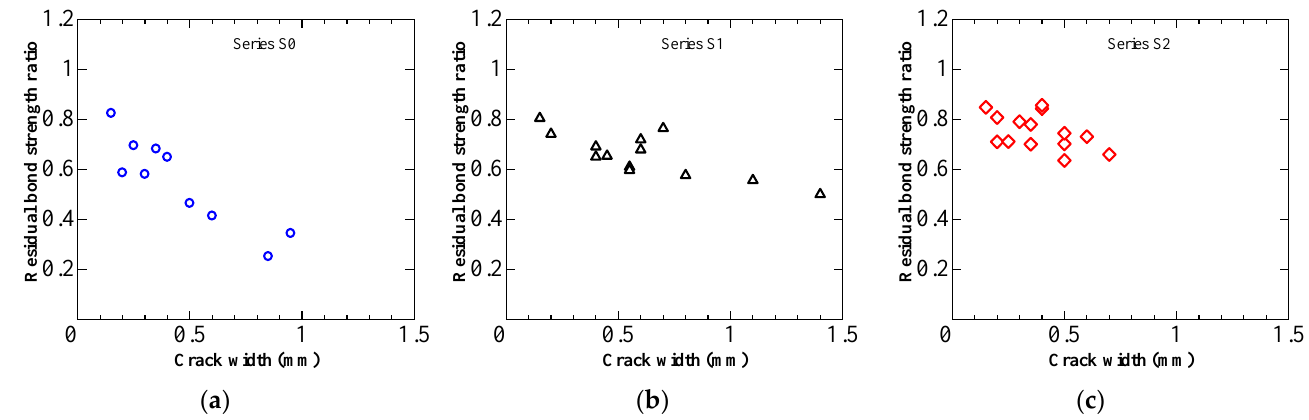
Figure 13. Residual bond strength ratio versus crack width : ( a ) series S0; ( b ) series S1; ( c ) series S2. Table 3. Regression analysis result.